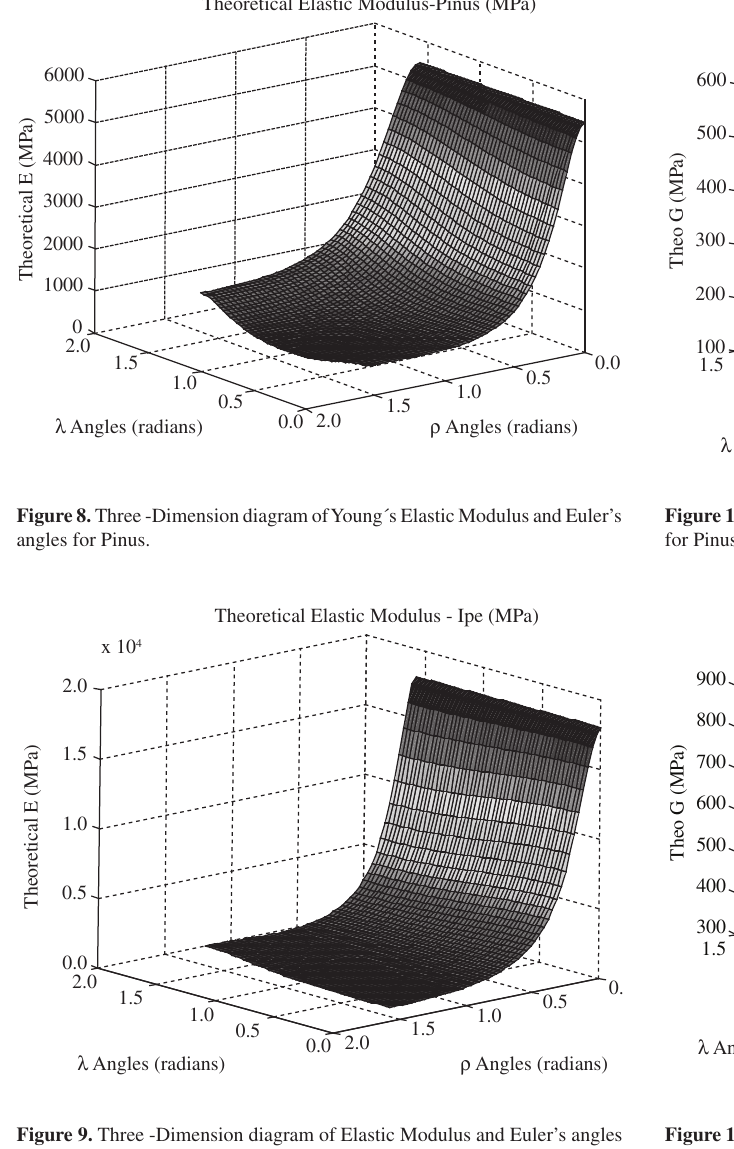
Table 2. Wood Elastic Constants ( E